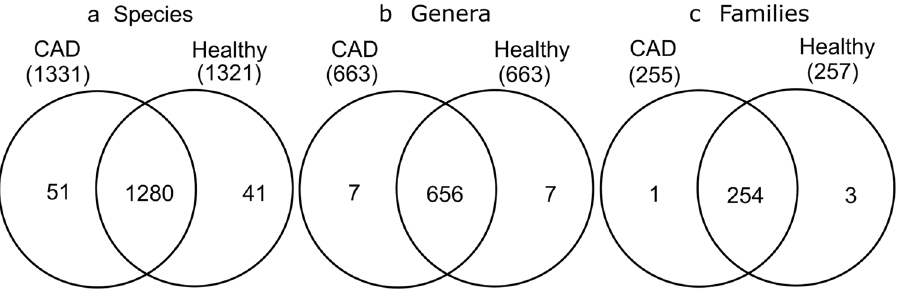
Figure 2. Number of ( a ) species, ( b ) genera and ( c ) families common to both CAD and healthy groups. The healthy group has a major amount of each of this